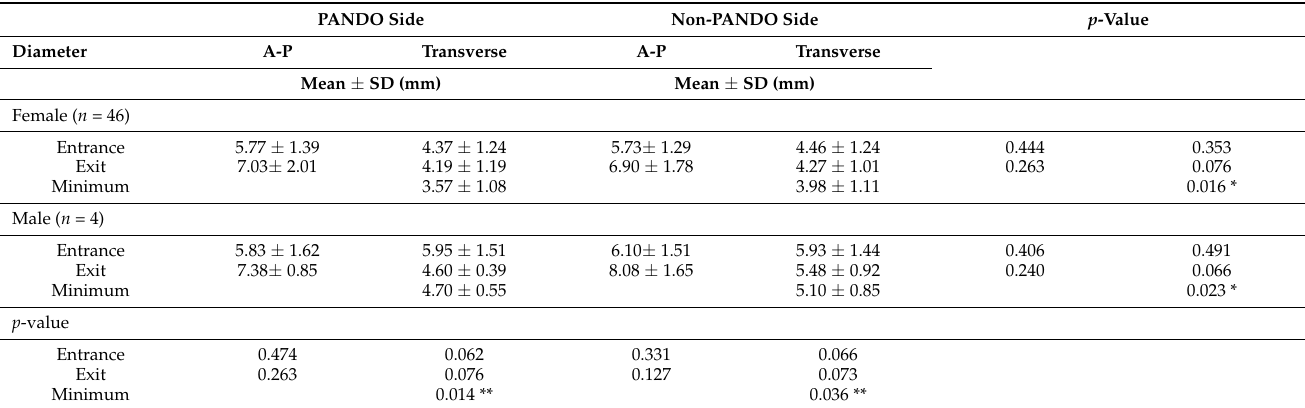
Table 2. Comparison of the bony nasolacrimal duct between sexes.